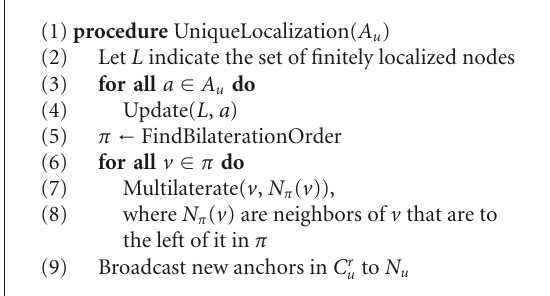
Algorithm 1: Iterated at u each time new anchors in A u are received from N u